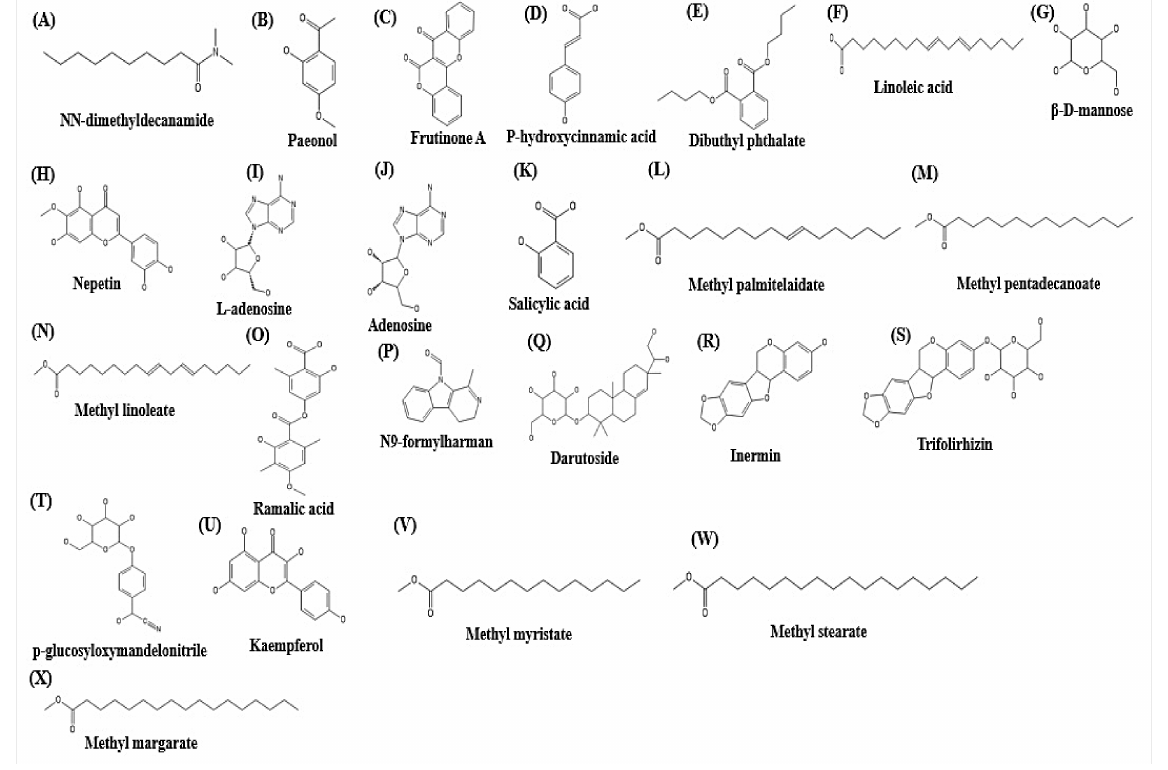
Figure 7. Chemical structures of potential bioactive compounds in PGCAM against COVID-19. 2.5. Affinity Score on Six Key Genes of Potential Bioactive Compounds in PGCAM against COVID-19 The potential bioactive compounds were docked against six genes (RELA,